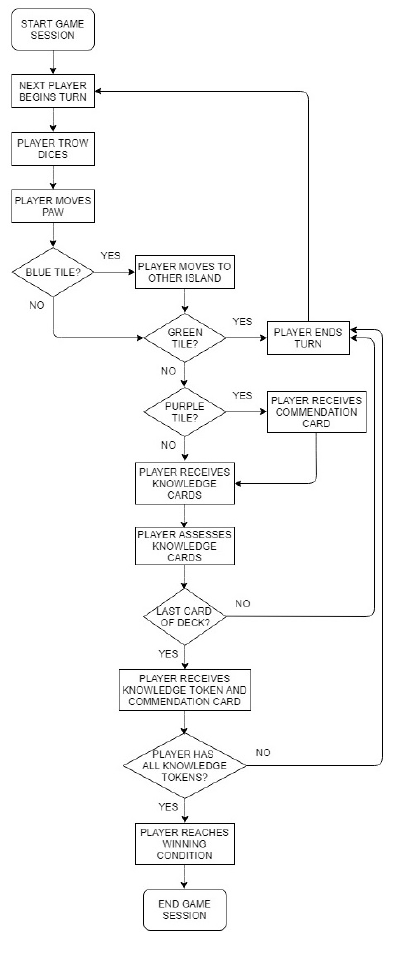
Figure 5. Diagram of a MARISA Game session. Table 3. List of the main MARISA Game